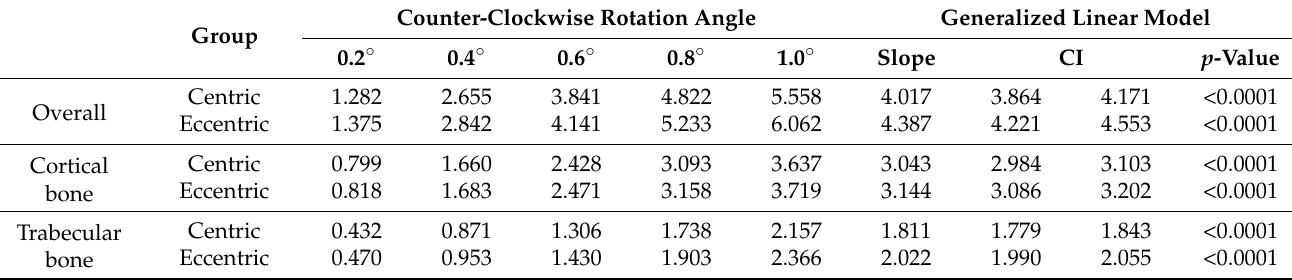
Table 6. Moment (Nmm) required to unwind the miniscrew for 0 ◦ to 1 ◦ of counter-clockwise rotation in 0.2 ◦ interval at each component of finite element model according to the position of the hole at the head part of the miniscrew placed with 60 ◦ angulation.